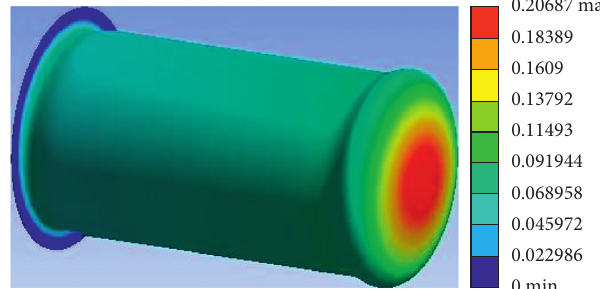
Figure 22: The total deformation cloud diagram of the flame tube in the coupled case.